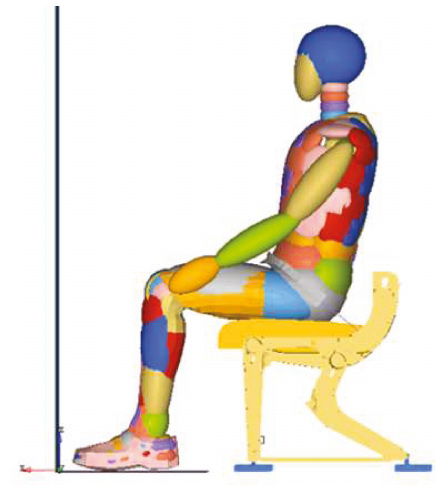
Figure 4: Hybrid model.